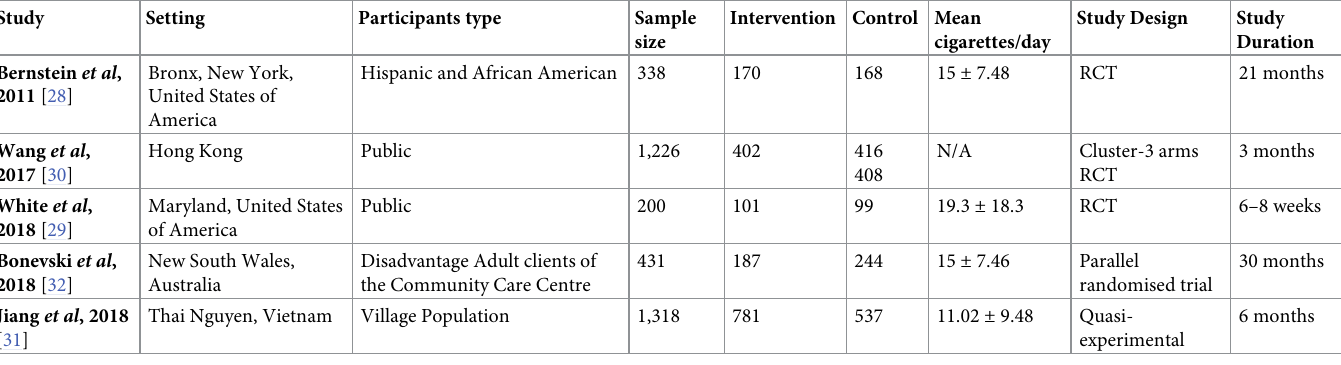
Table 1. Characteristics of the studies.